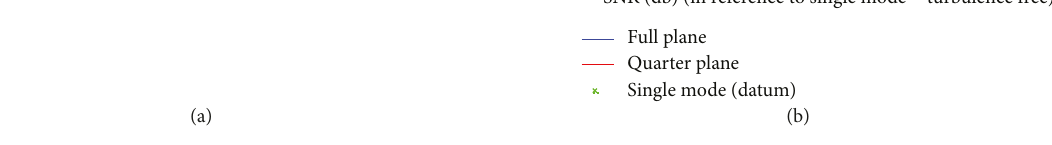
Figure 3: Quarter-area receiver performance: (a) BER performance (6 db loss), dotted lines: quarter-plane receiver and plain lines: full-plane receiver; (b) achieved rates and ( C 2 n = 10 − 15 ), λ = 632 8 × 10 − 19 ; L